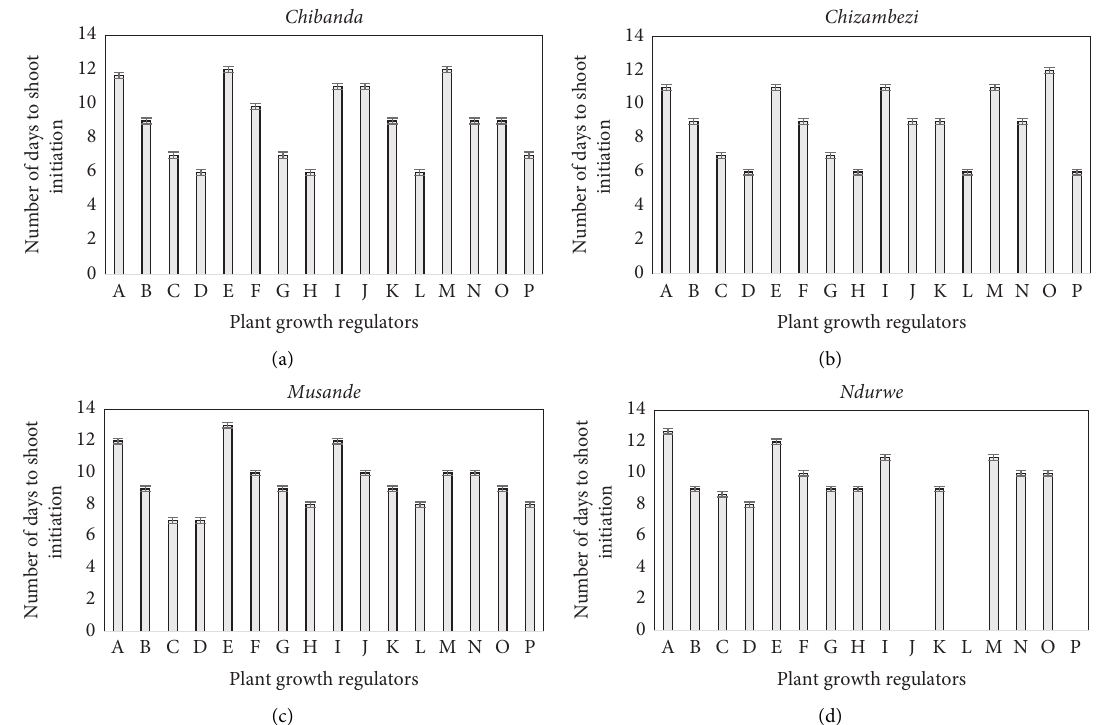
Figure 2: Mean days to shoot initiation of the Livingstone potato landraces in response to NAA: BAP in mg/l application. P < 0 . 001, LSD � 2.82. Error bars represent standard errors of the differences. Plant growth regulators key: A (0 mg/l : 0 mg/l), B (0 mg/l : 0.5 mg/l), C (0 mg/l :1 mg/l), D (0 mg/l : 2 mg/l), E (0.2 mg/l : 0 mg/l), F (0.2 mg/l : 0.5 mg/l), H (0.2 mg/l : 2 mg/l), I (0.5 mg/l : 0 mg/l), J (0.5 mg/l : 0.5 mg/l), J (0.5 mg/l : 0.5 mg/l), K (0.5 mg/l :1 mg/l), L (0.5 mg/l : 2 mg/l), M (1 mg/l : 0 mg/l), N (1 mg/l : 0.5 mg/l), O (1 mg/l :1 mg/l), and P (1 mg/l : 2